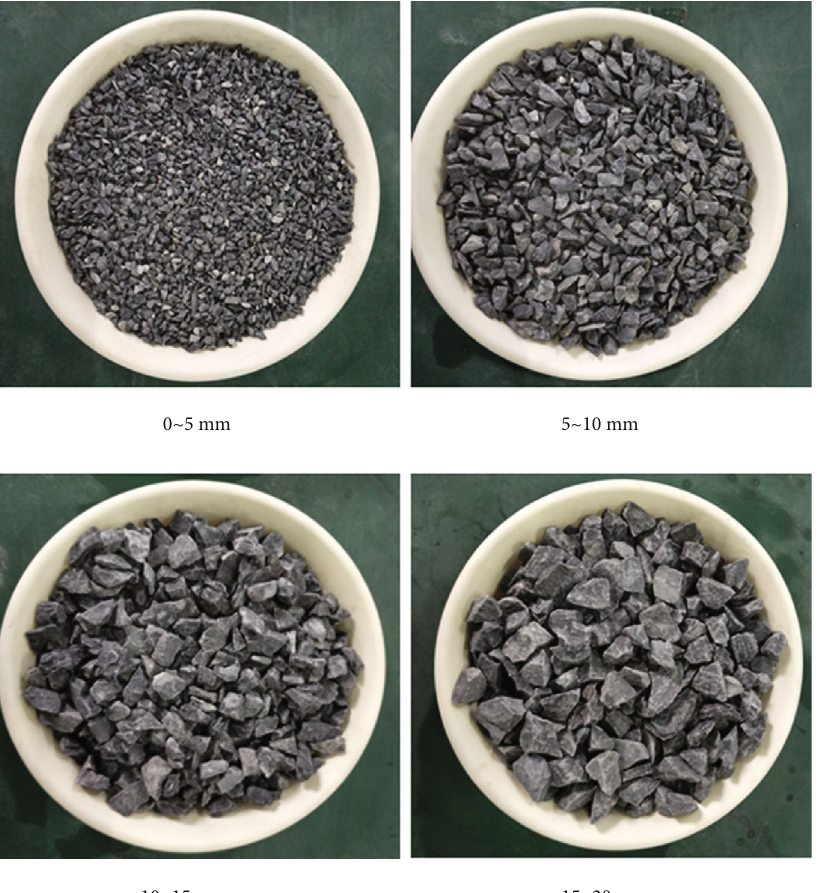
Figure 1: Pictures of the gangues with di ff erent sizes.